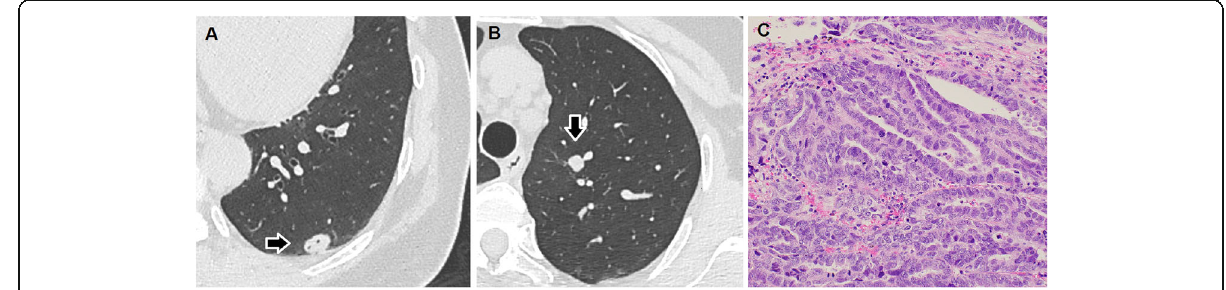
Fig. 2 Chest computed tomography showing a 1.3-cm-sized nodule with small airspace in the left posterior basal segment ( a ) and a 0.9-cm-sized solid nodule in the left apico-posterior segment ( b ). A histologic examination of the resected lung specimen resembling the previous primary peritoneal carcinoma. Irregular clusters of malignant cells with slit-like glandular spaces were observed. The tumor cells contained atypical large nuclei, prominent nucleoli, and frequent mitoses (× 200) ( c